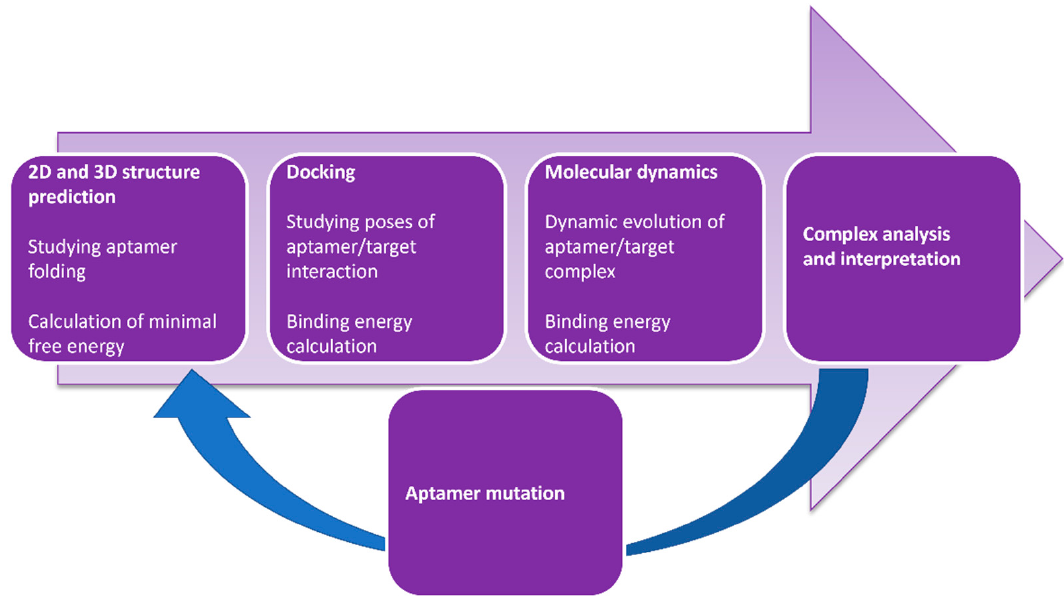
Figure 2. Schematic overview of a simulation-based workflow for the prediction of an aptamer’s structure and its interactions with its ligand. Through rational introduction of mutations or the use of genetic algorithms, the sequence of an aptamer can be altered, and a new round of simulation-based prediction of its improved affinity for its ligand can be undertaken [92].